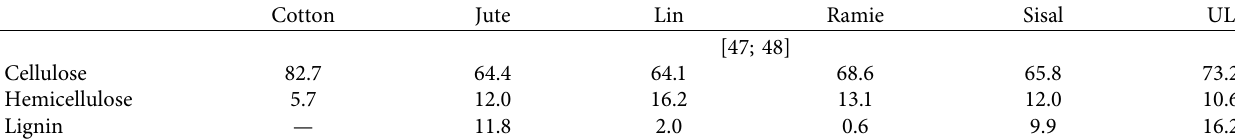
Table 2: Chemical composition of the UL fibre compared with fibres from other sources.